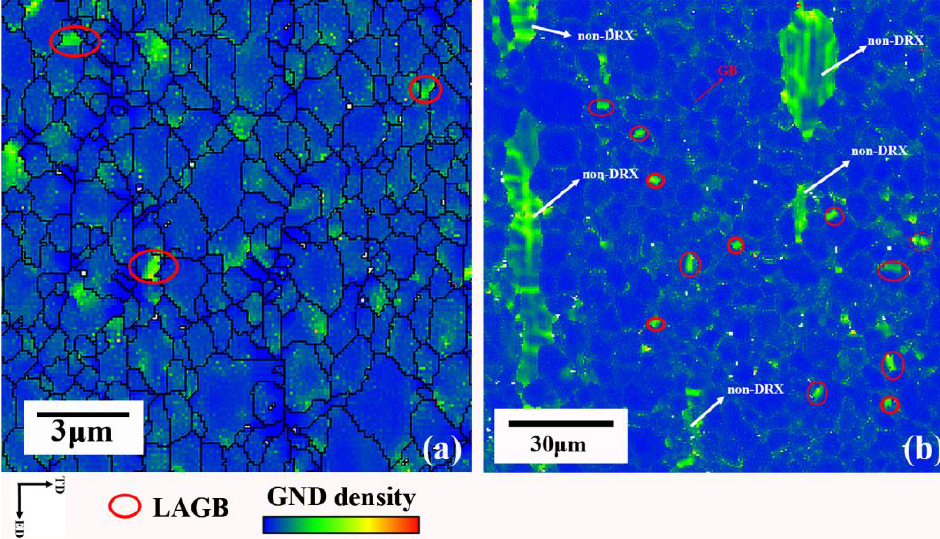
Figure 10. GND maps of ( a ) as-RS AZ31 extruded rod and ( b ) as-homogenized AZ31 extruded